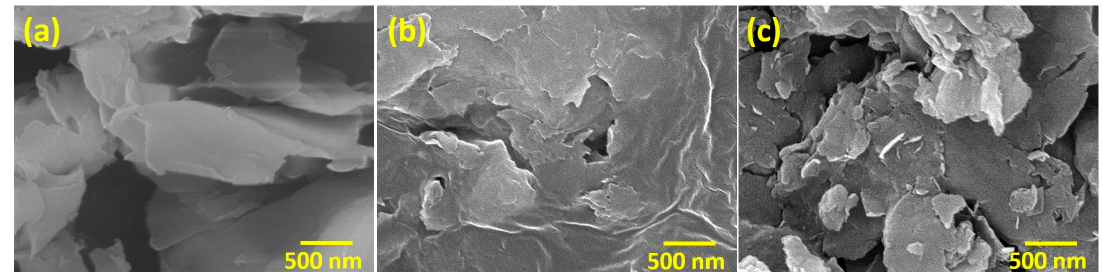
Figure 1. Representative scanning electron microscope micrographs: ( a ) organoclay; ( b ) PEI-clay; and ( c ) PI-clay.